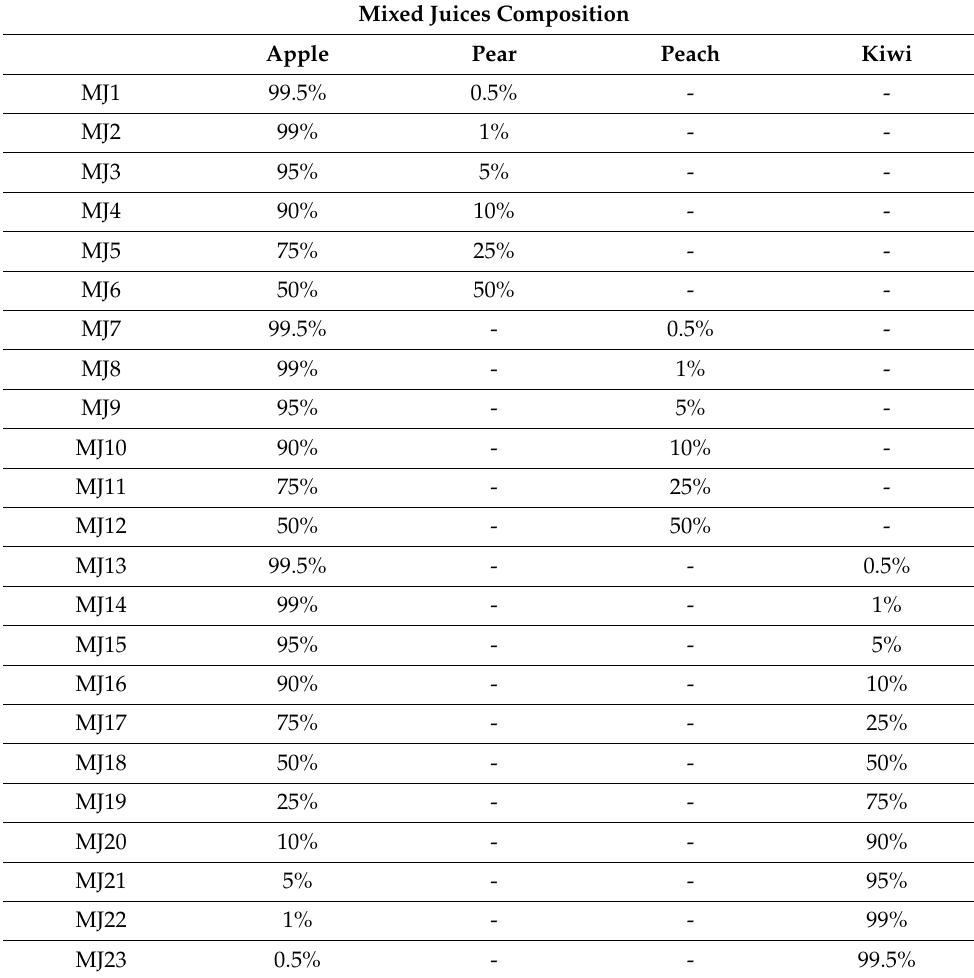
Table 1. Combinations of pure apple juice with pear, peach, and kiwi juices in known concentration. Mixed Juices